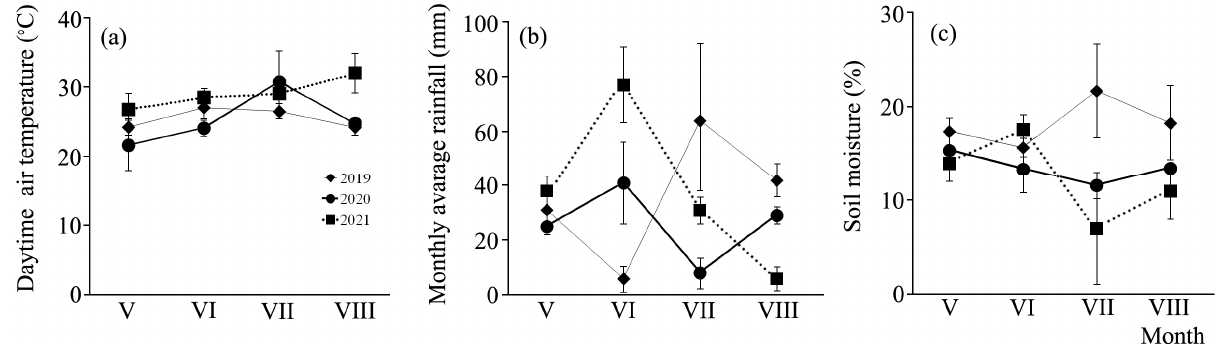
Figure 1. Dynamics of average air temperatures ( a ), precipitation ( b ) and soil moisture ( c ) content during the growing season of potatoes. V—May; VI—June; VII—July; VIII—August.